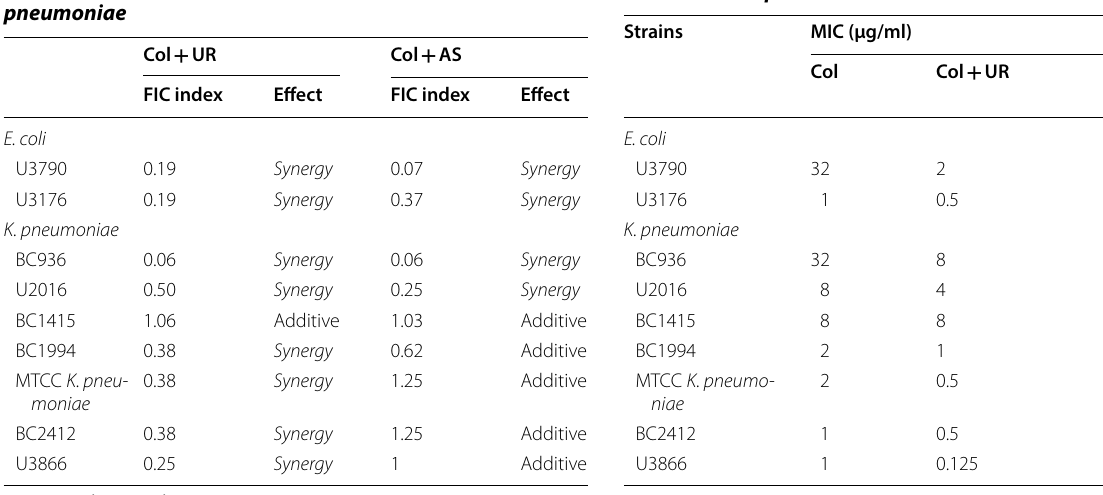
Synergy implies FIC values < 0.5